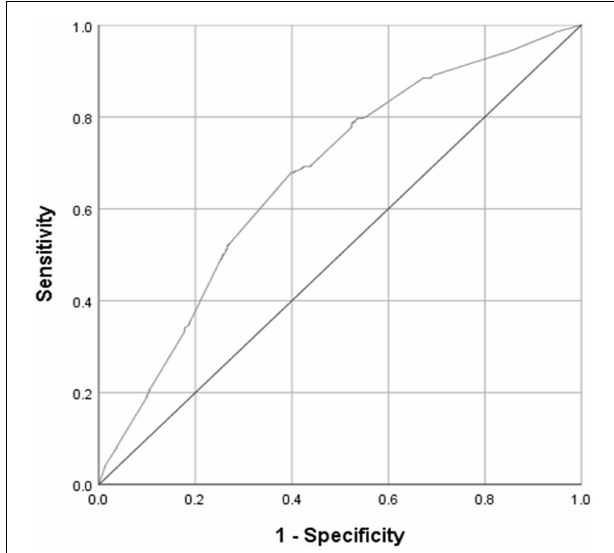
FIGURE 3 | Receiver operating characteristic (ROC) curve for the 1-item Distress Thermometer (DT), reference standard: any mental disorder (MD). Area under the ROC curve with 95% confidence interval (CI) is 0.67 (95% CI, 0.65–0.69; weighed sample, N =